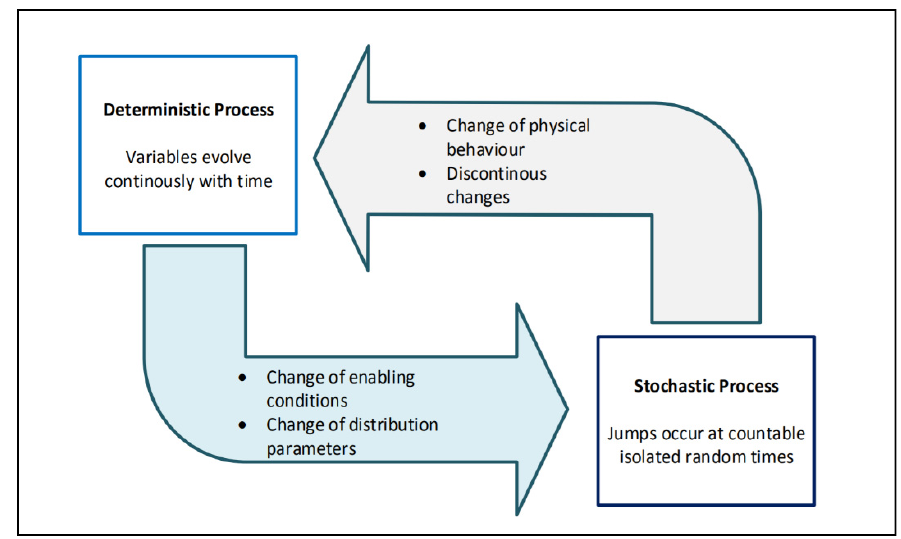
Figure 4. Coupling of the deterministic and stochastic process by mean of shared variables.